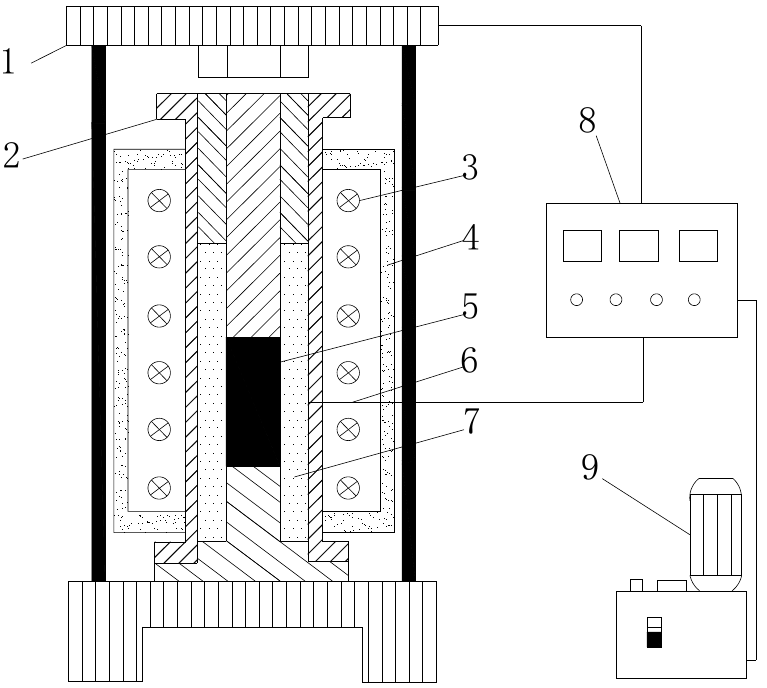
Figure 2. Schematic diagram of high-temperature triaxial pressure pyrolysis testing system: (1) support frame; (2) steel tube; (3) heating wire; (4) muff; (5) specimen; (6) thermocouple; (7) graphite packing; (8) temperature and pressure controller; and (9) oil pump.